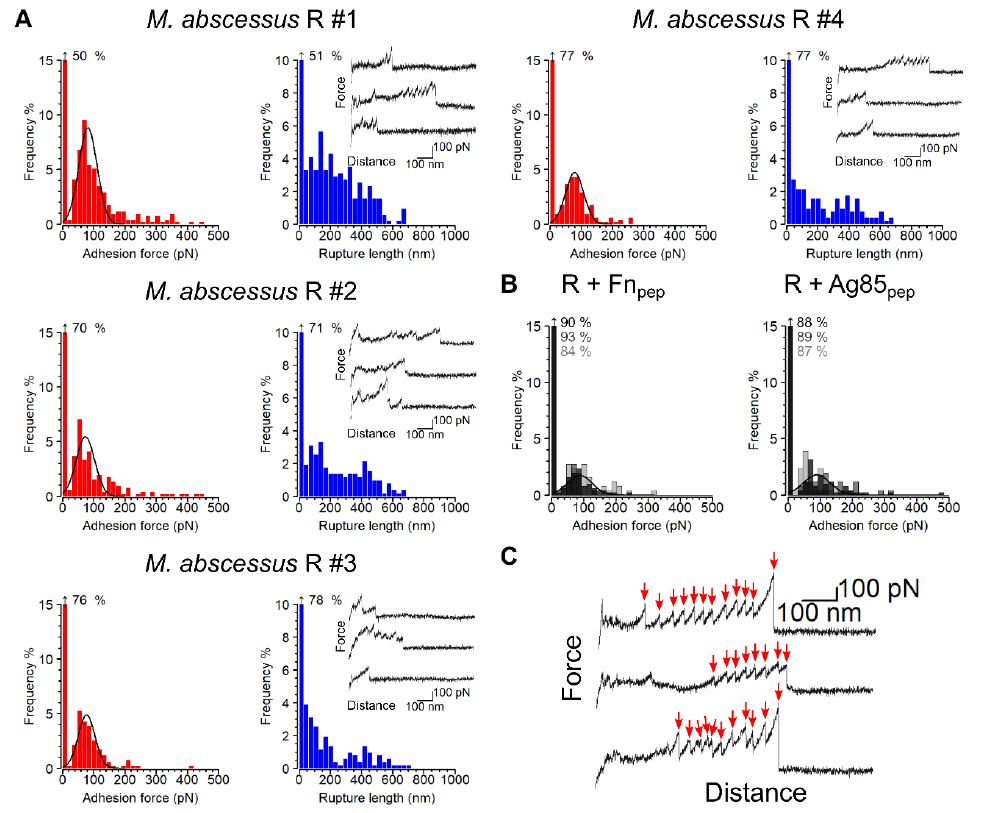
Figure 2. Force interactions between single M. abscessus R cells and Fn. ( A ) Adhesion force (left) and rupture length (right) histograms obtained for four M. abscessus R cells. An inset in the rupture length histograms shows three representative force-distance curves originating from the same dataset. ( B ) Injection of Fn pep (left) or Ag85 pep (right) both resulted in significant decreases in Ag85-Fn binding frequency. Shown are overlays of three adhesion force histogram plots obtained for three different cells. ( C ) Representative force-distance curves showing sawtooth patterns of successive unbinding events, the peaks being separated by approximately 28 nm (red arrows).